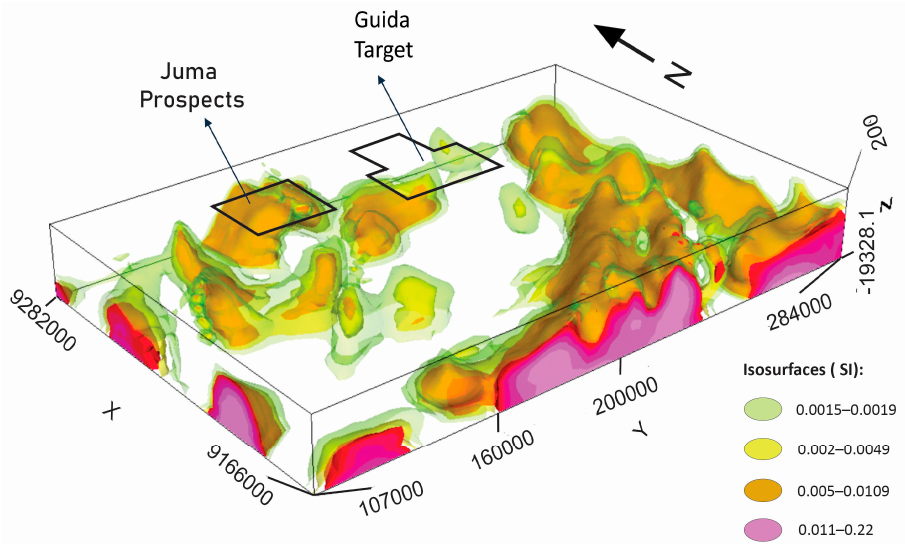
Figure 11. Juma District MVI model with the location of the Guida Target and the Juma prospects areas at a depth of 20km.